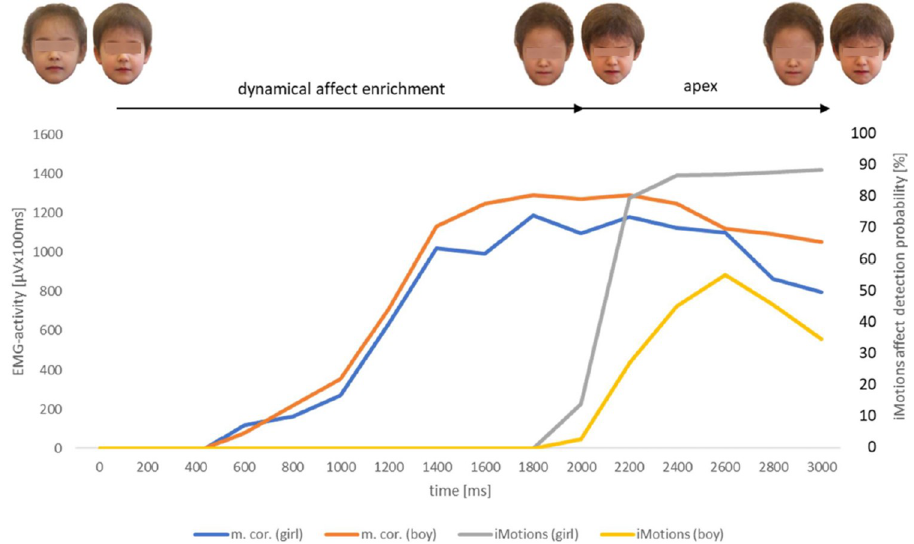
Fig 10. EMG-activity (N = 43) of m. corrugator [ μ Vx100ms] of healthy observers in response to the presented videoclips displaying the facial expression of anger naturalistic evolving from a neutral face of the girl’s respective boy’s reference portrait; software based (AFFDEX/iMotions) affect detection probability values [%] of the same presented stimuli; measurement interval for both procedures 3000ms. m.cor. (girl) = EMG-activity of musculus corrugator in response to the girl’s face video. m.cor. (boy) = EMG-activity of musculus corrugator in response to the boy’s face video. iMotions (girl) = software based affect detection probability [%] in response to the girl’s face video. iMotions (boy) = software based affect detection probability [%] in response to the boy’s face video.